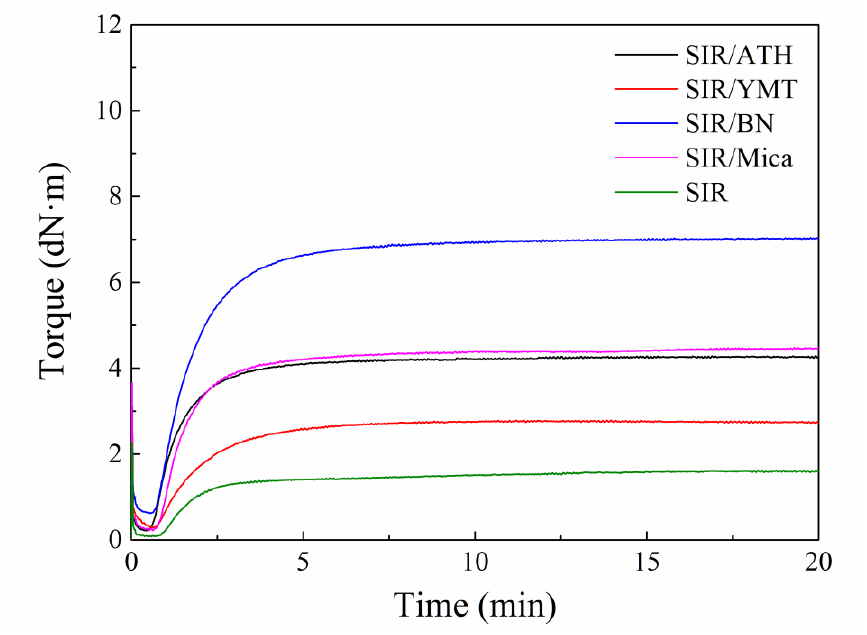
Figure 1. Vulcanization curve of SIR composite with different fillers.